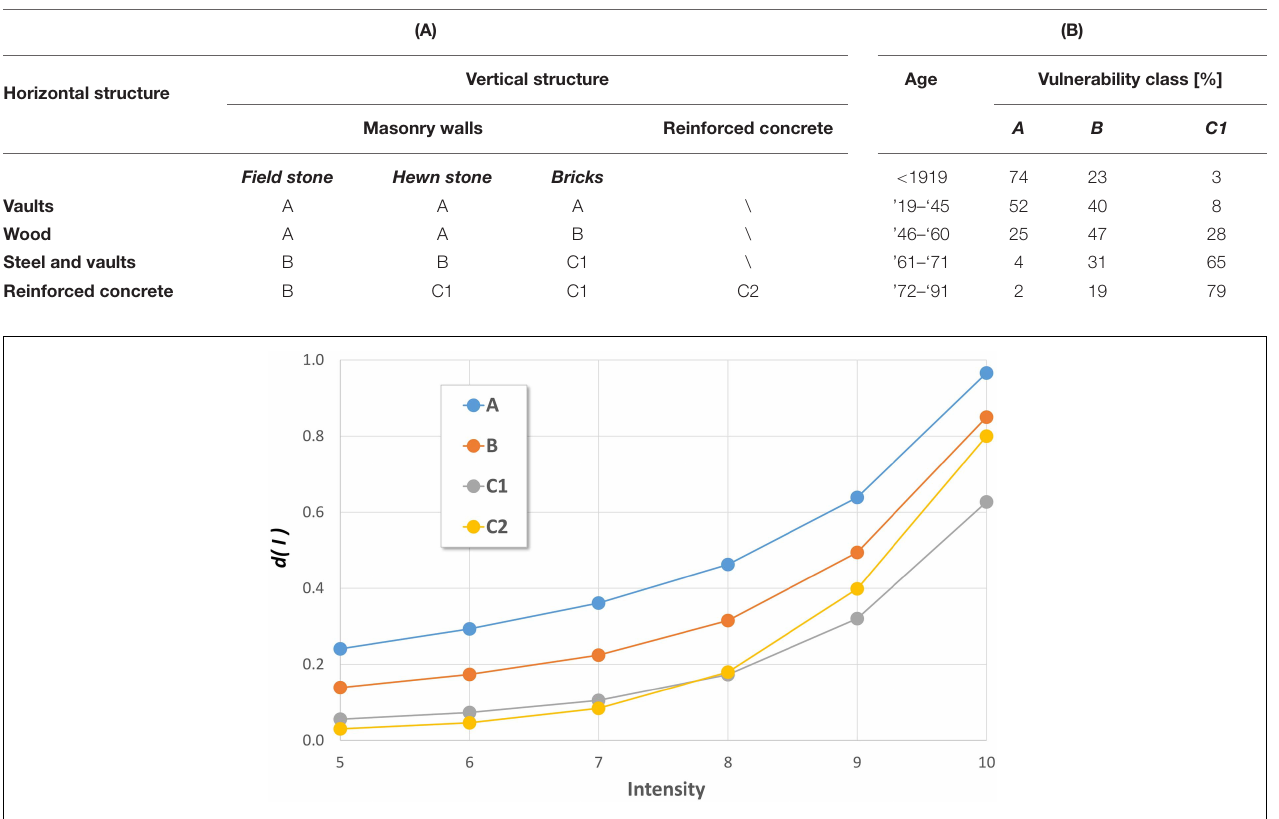
FIGURE 6 | Values of average damage d(I) of the binomial function p k , for each vulnerability class and EMS intensity (Di Pasquale and Orsini, 1997, 1998; Di Pasquale et al., 2005)